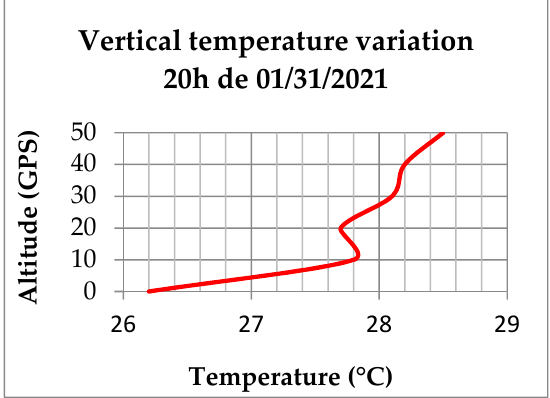
Figure 9. Vertical temperature at 8 p.m.